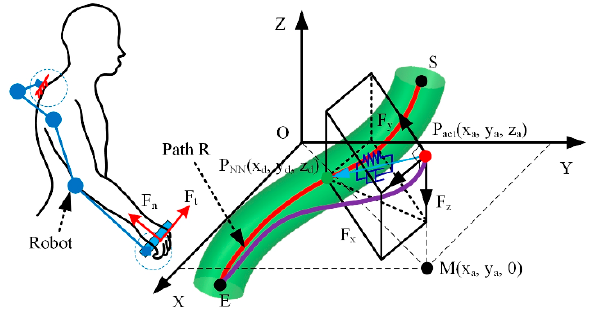
Figure 4. Schematic diagram of the spatial virtual channel.